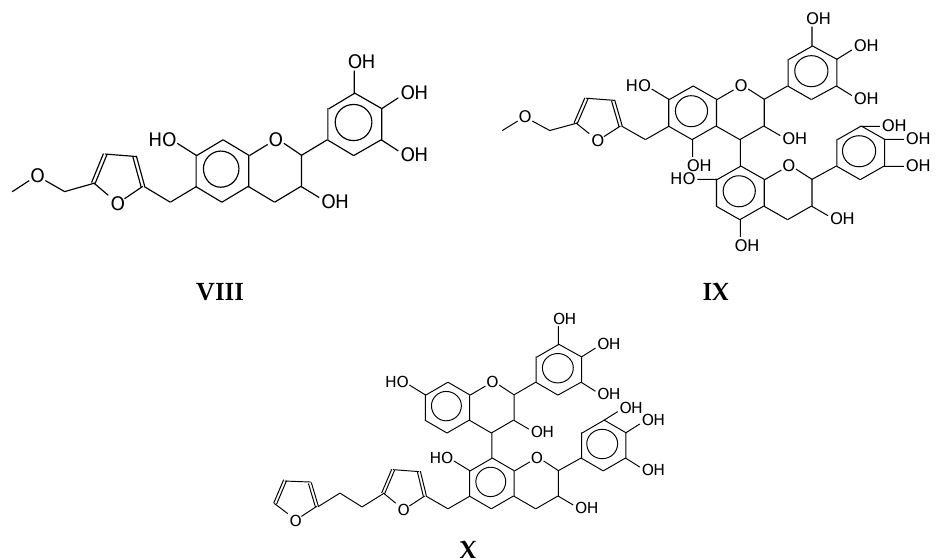
Figure 13. FT-IR of the different mixes of humins (H) and furfuryl alcohol (FA) used for the preparation of the tannin – humins